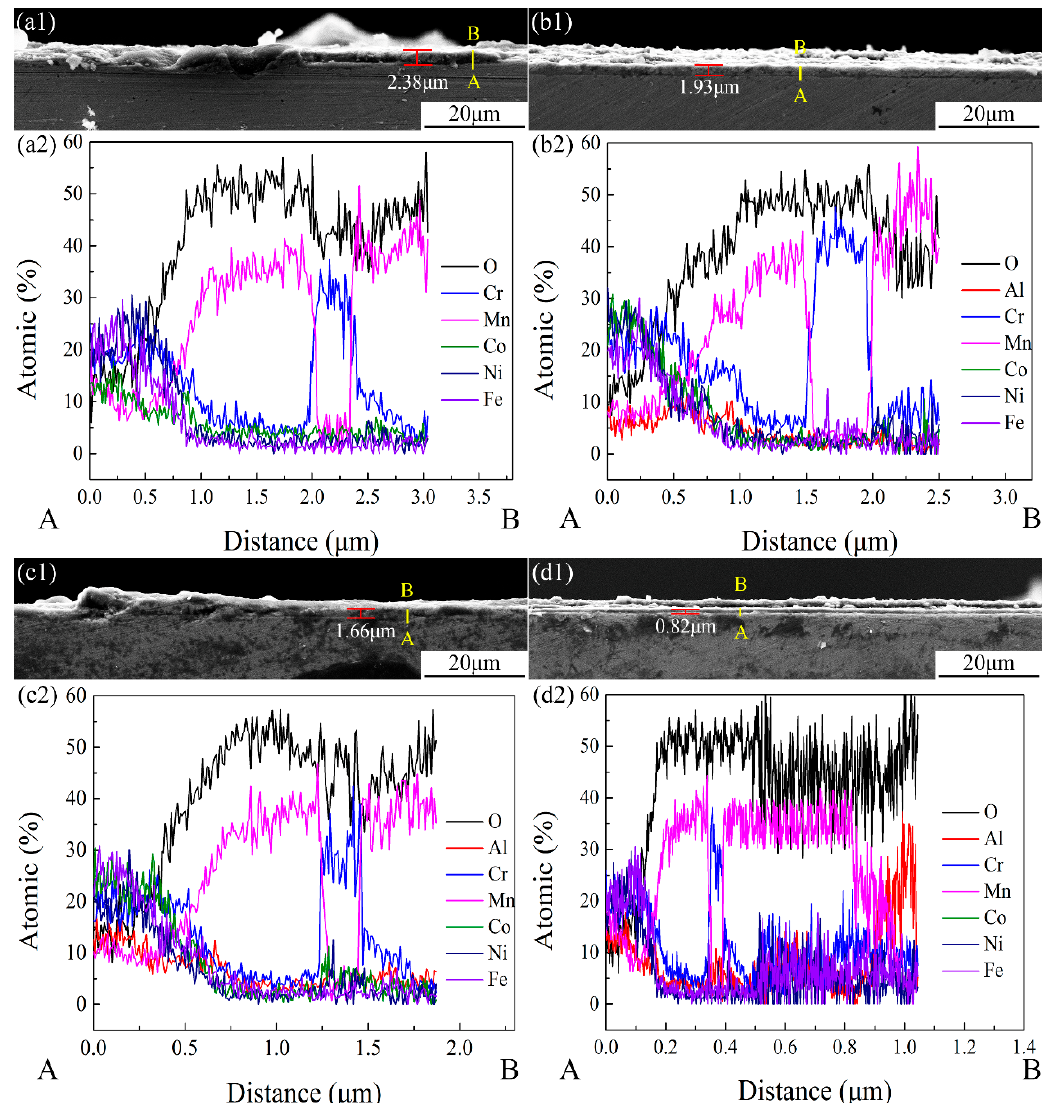
Figure 8. Microstructures and EDS results of the cross-sections of oxide films on the surface of the FeCoCrNiMnAl x cladding layers: ( a1 , a2 ) x = 0; ( b1 , b2 ) x = 0.25; ( c1 , c2 ) x = 0.5; and ( d1 , d2 ) x =